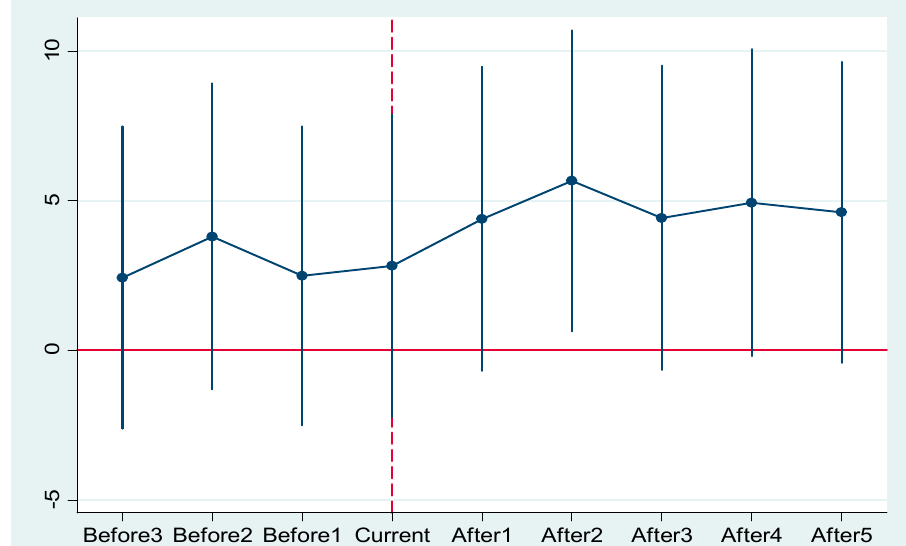
Figure 2. Parallel trend test.